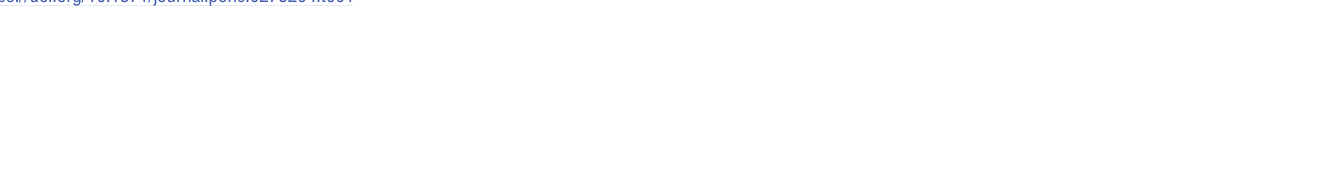
1 Derived indicators, computed by variables registered by CRV. 2–4 Removed indicator due to P-value of univariate analysis < 0.25 in model of age of culled milking cows, lifetime milk production of culled milking cows and culling rate, respectively. 5 The value of variable in 5 or 95